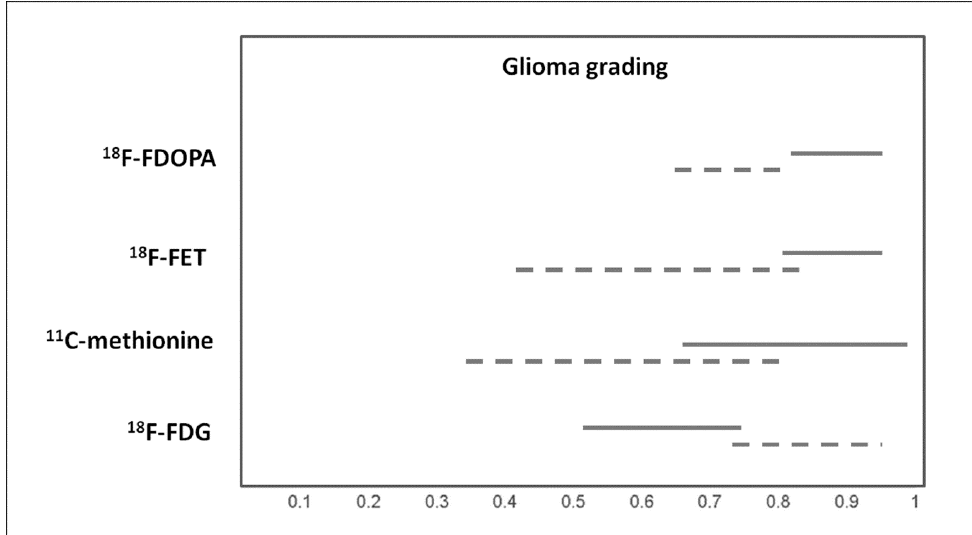
Figure 3. Graph showing 95% confidence intervals of sensitivity (continuous line) and specificity (dashed line) of PET with different tracers for glioma grading, according to published meta-analyses.